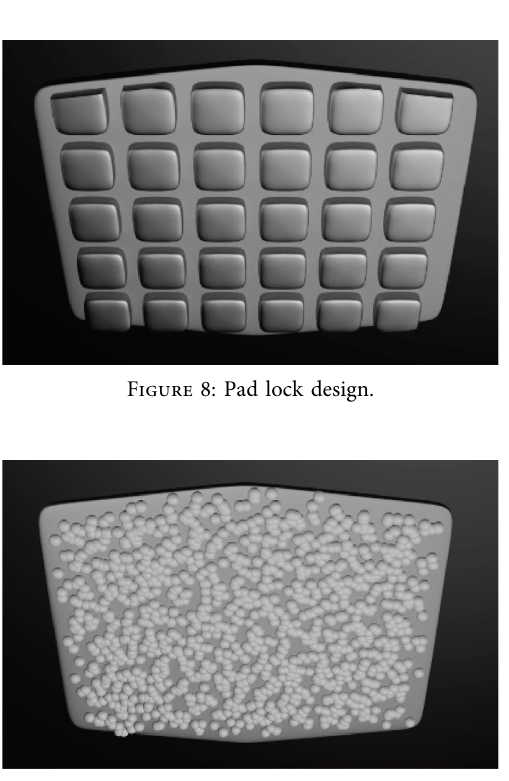
Figure 9: Added spherical ceramic particles.